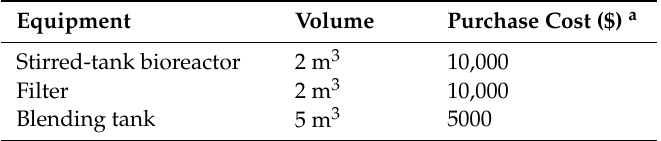
Table 6. Major equipment purchase and installed costs of reductive amination.